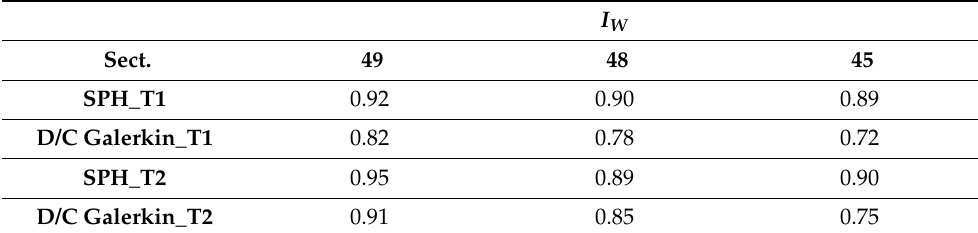
Table 4. Statistical analysis of the comparison of the free surface for T1 and T2. I W Sect. 49 48 45 SPH_T1 0.92 0.90 0.89 D/C Galerkin_T1 0.82 0.78 SPH_T2 0.95 0.89 0.90 D/C Galerkin_T2 0.91 0.85